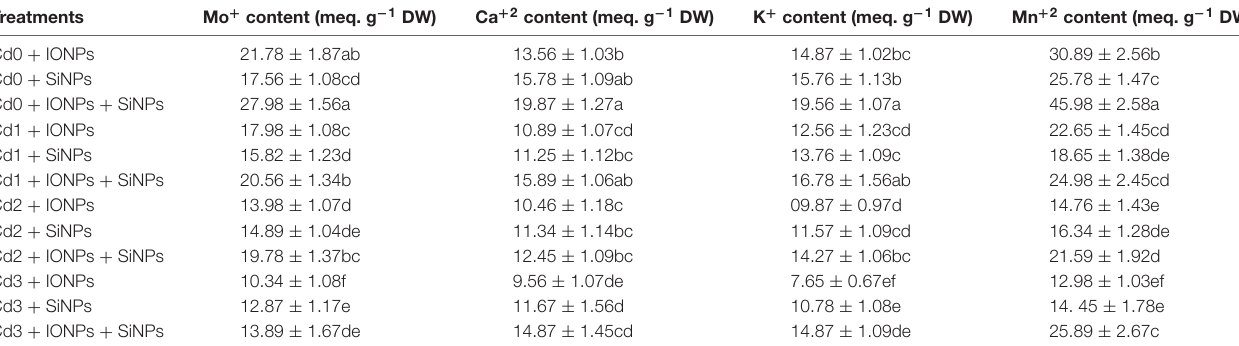
TABLE 4 | Effect of IONPs and SiNPs on Mo + , Ca + , K + , and Mn + of Phaseolus vulgaris grown in different concentrations of Cd.